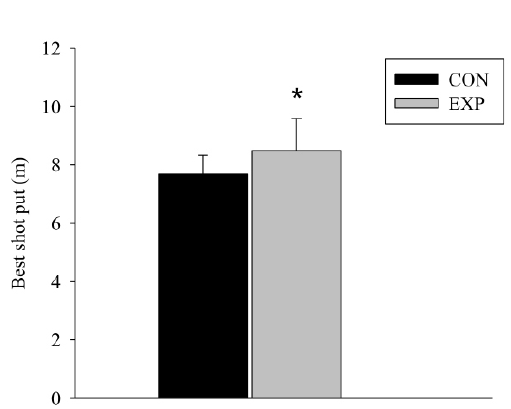
Figure 1. Mean ± SD of the shot put CON and PB situation.[*] p< 0.05, maior que CON).